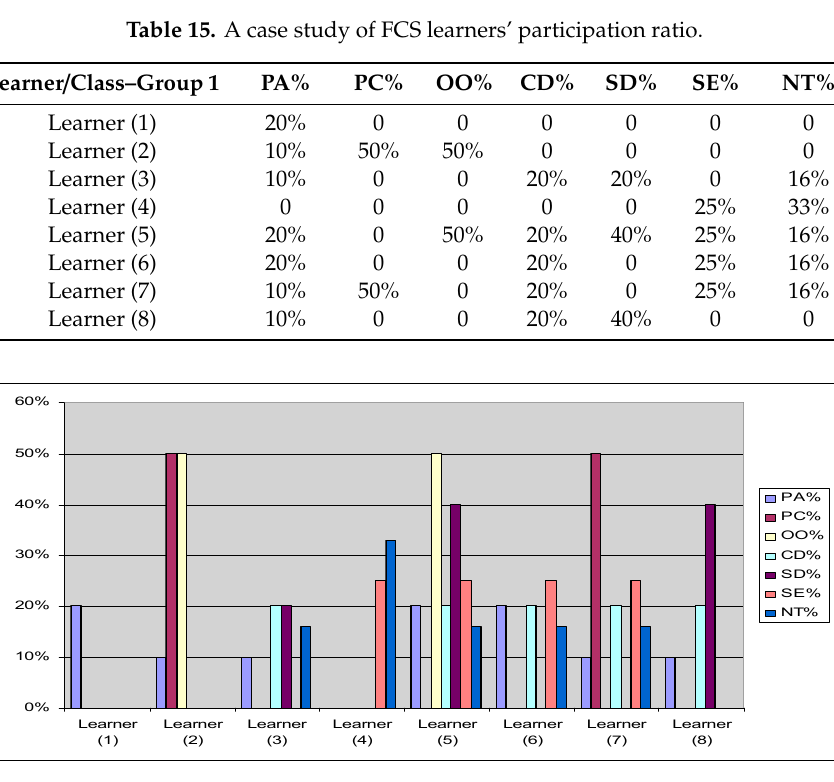
Figure 22. Learners’ participation ratio graph for Group 1.